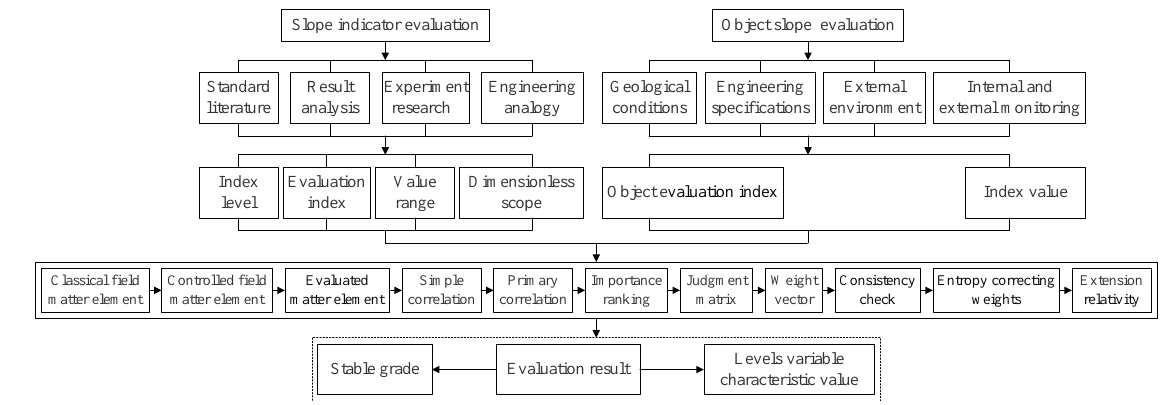
Figure 2. Evaluation flowchart of high rocky slope